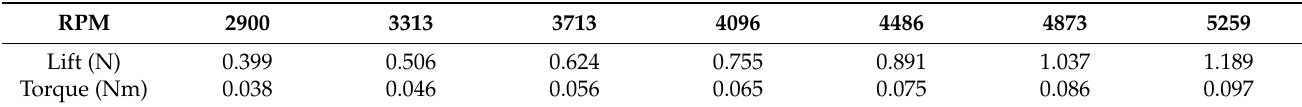
Table 2. MAS Experimental results of rotor with rectangular